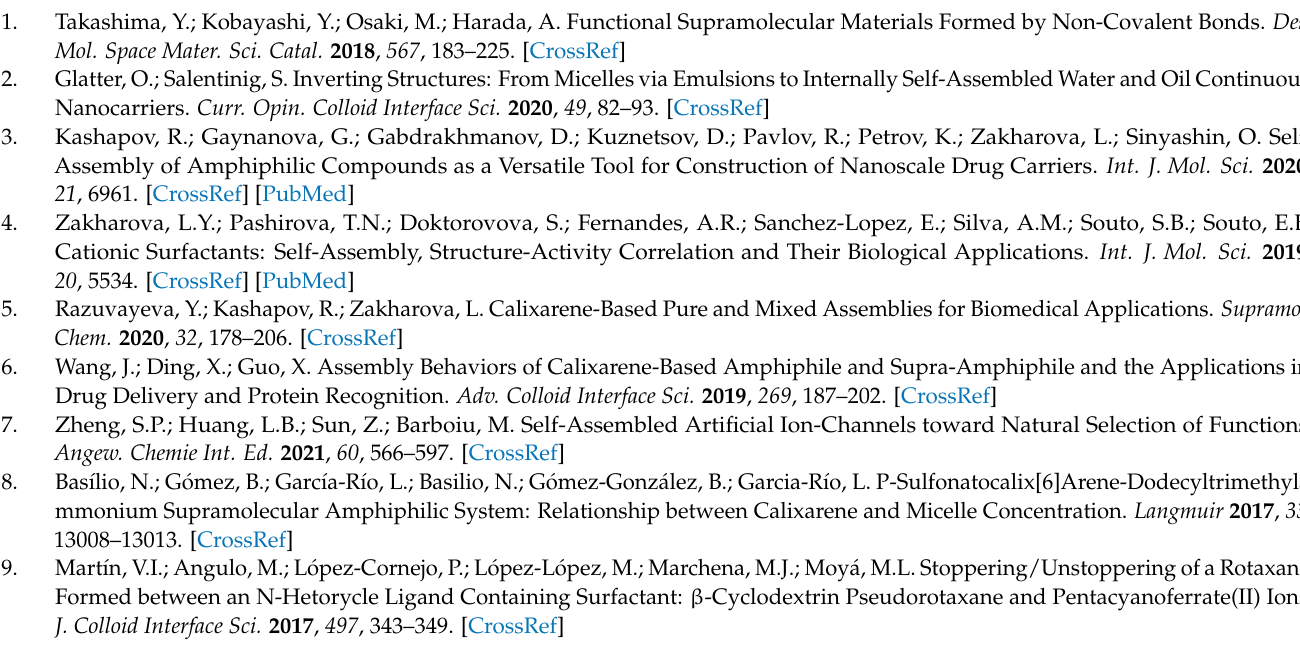
cisplatin; Table S2: Self-diffusion coefficients (D s ) values for TSPP and LaSurf in their mixtures with cisplatin in D 2 O, 300 K; Table S3: Values of the half-maximal inhibitory concentration (IC 50 ) in Chang liver and M-Hela cells for free TSPP and binary TSPP − LaSurf systems; Table S4: Values of TSPP − LaSurf